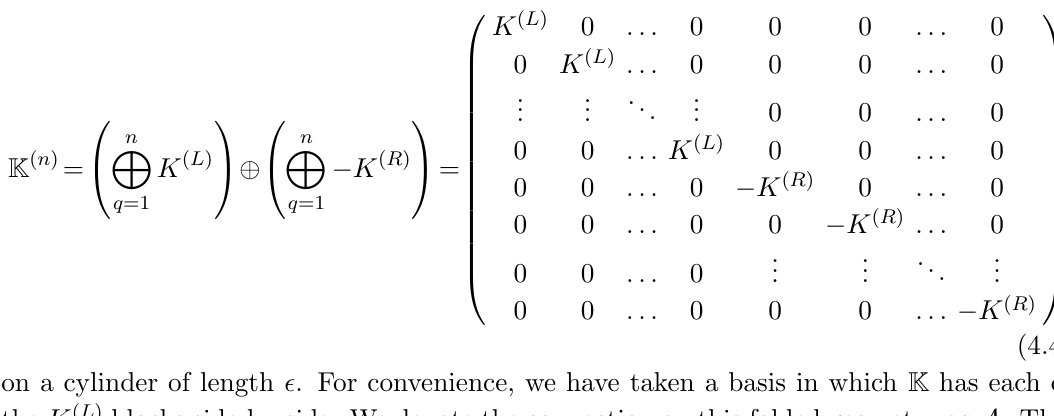
Figure 6 . Replica path integral with n = 2. We (cid:12)rst conformally map to S \fold" with parity transformations on the K ( R ) phases. The edges at the fold determine topological boundary conditions M i; . Alternatively this can be packaged as a larger CS theory with a 2 nN (cid:6) 2 nN K -matrix, K ( n ) and the edges have topological boundary conditions M ( n )